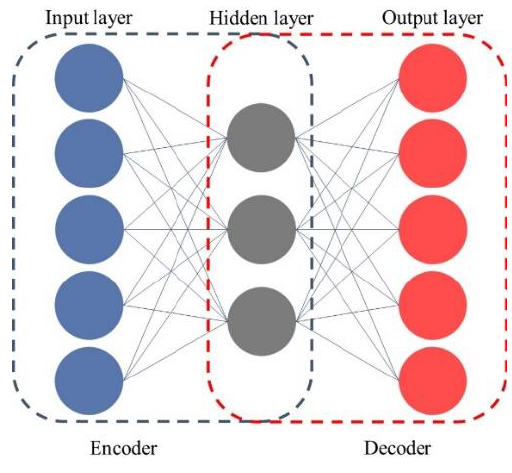
Figure 1. The basic structure of an autoencoder.